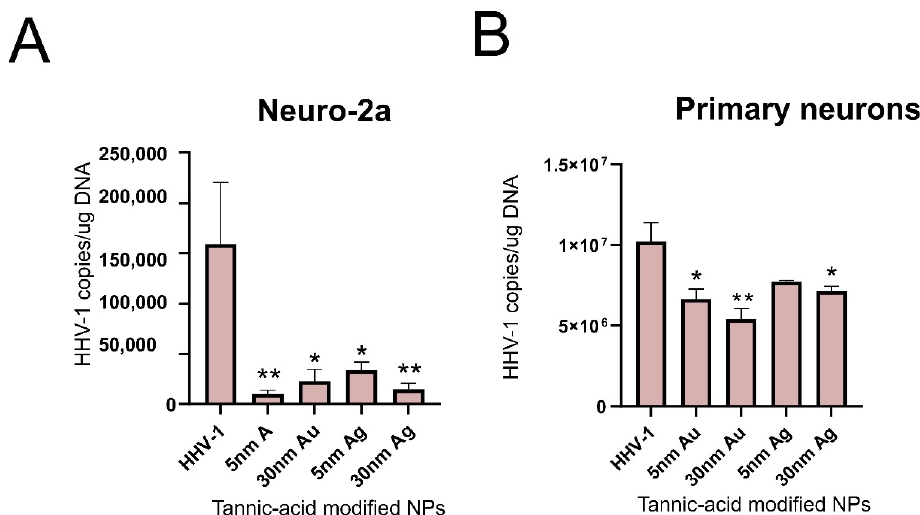
Figure 3. Tannic-acid modified Ag/AuNPs (TA- Ag/AuNPs) block HHV-1 infection in Neuro-2a cell line ( A ) and primary neurons culture ( B ). Both cell cultures were pre-treated for 6 h with a non-toxic concentration of tannic acid-modified AgNPs, or AuNPs sized 5 and 30 nm (2.5 µg/mL). At 24 h p.i., cells were subjected to HHV-1 copies titration by qPCR. The data are expressed as means from three independent experiments ± SEM. * represents significant differences with p ≤ 0.05, ** p ≤ 0.01 in comparison to untreated infected control (two-way ANOVA test). The figure presents our own unpublished